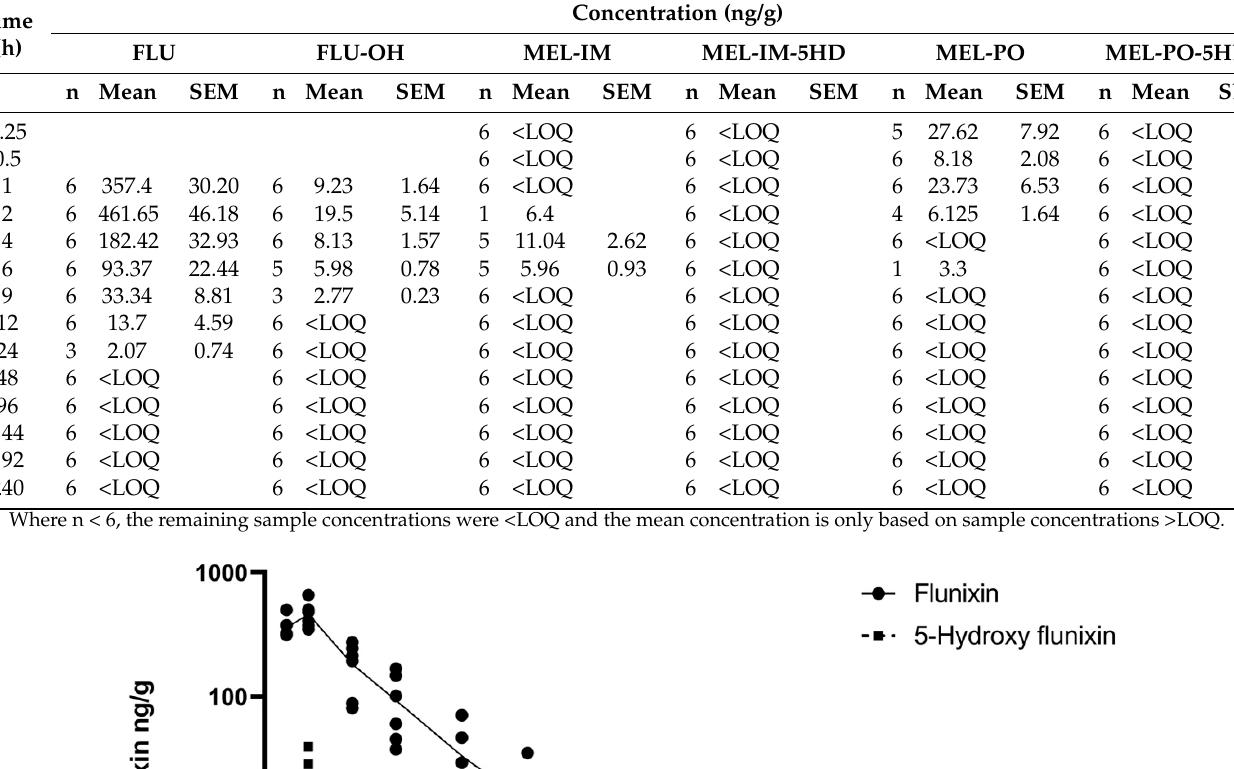
Table 4. Mean ± SEM parent drug and metabolite concentration in tissue after administration of a single dose of flunixin (2.2 mg/kg) intramuscularly or meloxicam (1 mg/kg) intramuscularly or orally (n = 6) in tilapia.